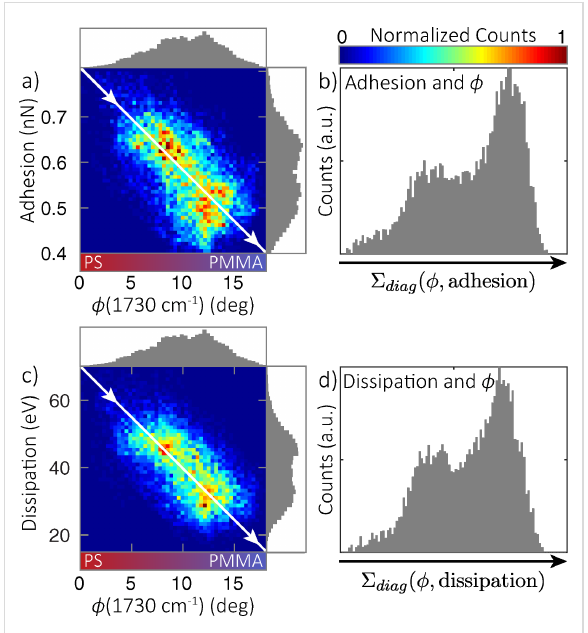
Figure 5: Bivariate and corresponding coincidence histograms showing correlations between adhesion and (1730 cm − 1 ) (a,b), and dissipation and (1730 cm − 1 ) (c,d). Histograms of each single channel are shown along the corresponding axis in (a) and (c). Coincidence histograms (b,d) calculated by summing counts in the bivariate histograms (a,c) along diagonal lines perpendicular to the direction of correlation (solid line). A bimodal distribution is apparent, indicative of separate populations of distinct chemistry and nanomechanical proper- ties.